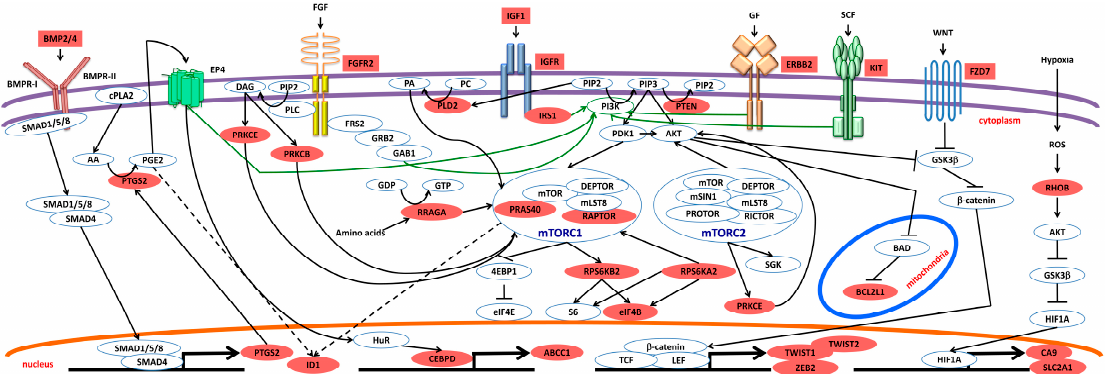
Figure 6. Potential activated pathways and targets in R1-cell derived tumor xenograft. Solid arrows indicate connections that are well established. Dashed arrows indicate less well established and/or more controversial. Light red color denotes detected upregulation.